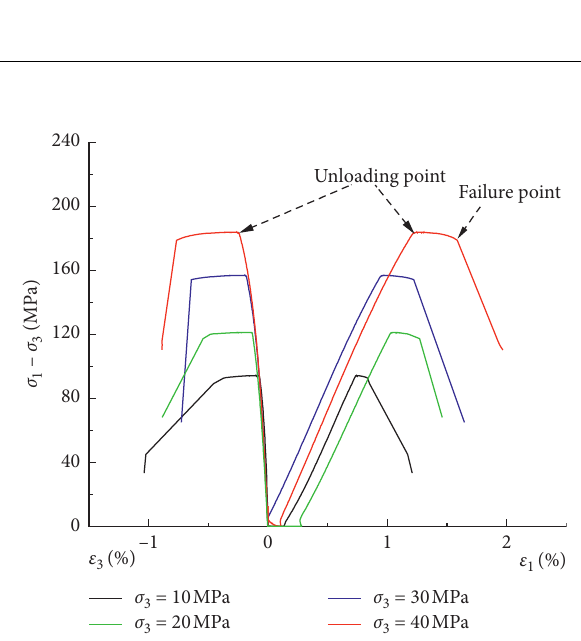
Figure 4: Typical stress-strain curve of sandstone under unloading